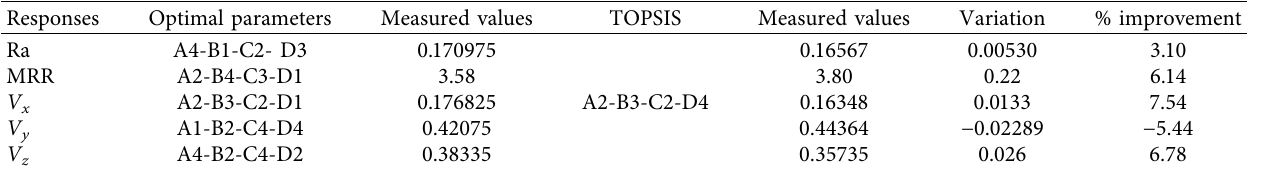
Table 10: Confirmation test